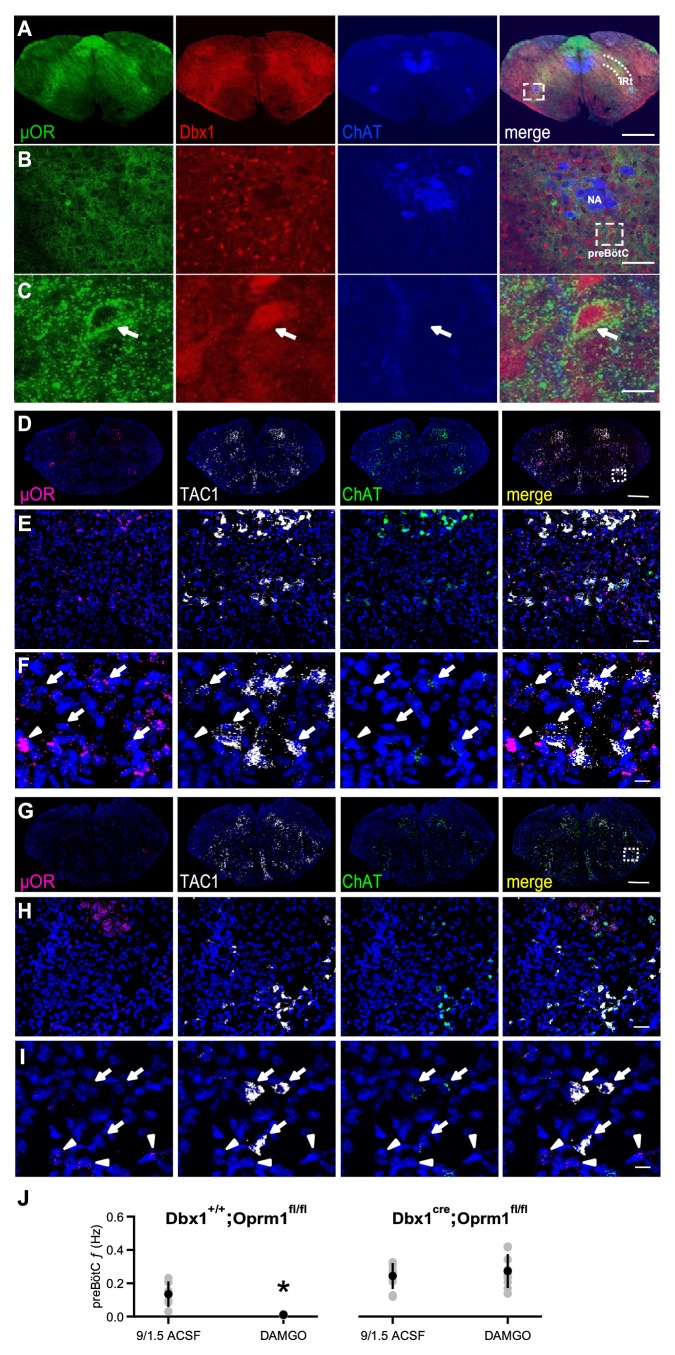
µORs expressed in Dbx1+ neurons mediate DAMGO inhibition of preBötC rhythmic activity.(A) Confocal images of brainstem sections of a Dbx1Cre;Rosa26tdTomato mouse pup (P2) double-stained with antibodies to Choline acetyltransferase (ChAT; blue) and µOR (green). Coronal sections showing µOR expression in the preBötC and the Intermediate band of the Reticular Formation (IRt) and colocalization with Dbx1+ neurons in the preBötC. Scale bar, 500 μm. (B) Higher magnification of nucleus ambiguus (NA) and preBötC from the boxed region in A. Scale bar, 50 μm. (C) Expanded images of the boxed preBötC region highlighted in B. The arrow shows a preBötC Dbx1+ neuron with abundant punctate µOR expression on the cell body. Scale bar, 10 μm. (D) Confocal image of a medullary brainstem section at the level of the preBötC from a control P2 Dbx1+/+;Oprm1fl/fl mouse processed with RNAScope. Probes for µOR (magenta), tachykinin precursor 1 peptide (TAC1; white), and ChAT (green) were used, and the tissue was counterstained with DAPI (blue). A box marks the location of preBötC. Scale bar, 1 mm. (E) Higher magnification of the boxed preBötC region in D. µOR and TAC1 were highly expressed in this region. Scale bar, 100 μm. (F) Higher magnification images of TAC1-positive neurons and µOR mRNA (arrows). Colocalization of TAC1 and multiple µOR puncta was observed in several neurons (arrows) as well as abundant µOR puncta in negative TAC1 regions (arrowhead). Scale bar, 40 μm. (G) Confocal image of a medullary brainstem section at the level of the preBötC from a P2 Dbx1cre/cre;Oprm1fl/fl mouse processed with RNAScope. Probes for µOR (magenta), TAC1 (white), and ChAT (green) were used, and the tissue was counterstained with DAPI (blue). In the preBötC of these mice, the density of µOR puncta was low. A box marks the location of preBötC. Scale bar, 1 mm. (H) Higher magnification of the boxed preBötC region in G. The density of µOR puncta was low, and µOR expression was not associated with TAC1 expression. Scale bar, 100 μm. (I) Higher magnification images of TAC1-expressing neurons from H with few to no µOR puncta, as well as µOR transcripts without TAC1 expression (arrowheads). Scale bar, 40 μm. (J) Average f of preBötC activity in control 9/1.5 conditions and 100 nM DAMGO in Dbx1Cre;Oprm1fl/fl mice (right), where µORs are selectively deleted in Dbx1+ neurons, and their Dbx1+/+;Oprm1fl/fl littermate controls with preserved µOR expression (left). Whereas 100 nM DAMGO reduced preBötC f significantly in Dbx1+/+;Oprm1fl/fl control mice, the same concentration had no effect on f when µORs were deleted. *, p<0.05, Student’s t-test, n = 6 for Dbx1+/+;Oprm1fl/fl, n = 9 for Dbx1Cre;Oprm1fl/fl.